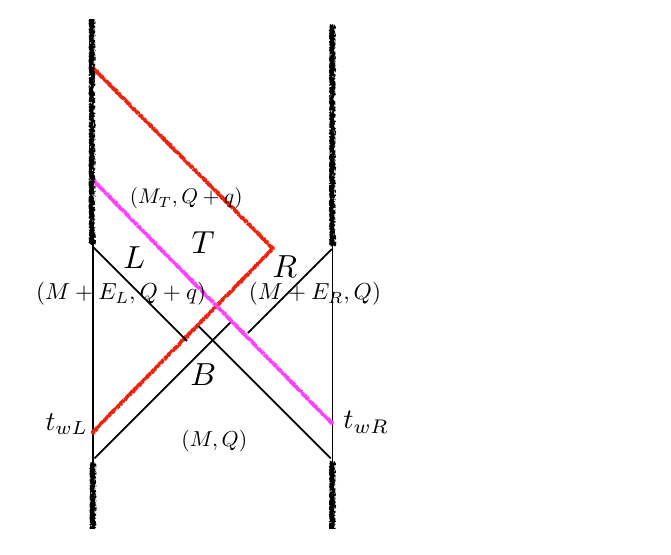
Figure 14 . Geometry with a neutral shockwave colliding with a charged